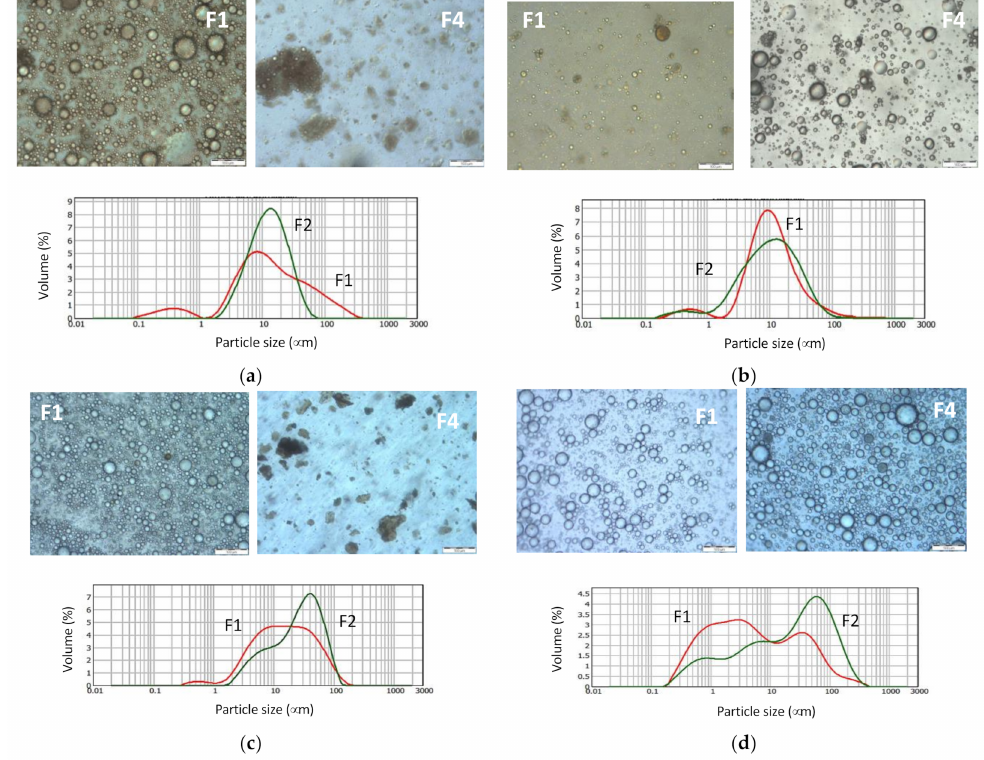
Figure 7. Aqueous dispersions obtained by hydrating dried fractions collected during extraction with ( a ) EtOH 58, ( b ) EtOH 86, ( c ) iPro 60, ( d ) iPro 90. Scale bar of 100 µ m for microscopy images; image of F1 iPro 90 obtained after dilution of the